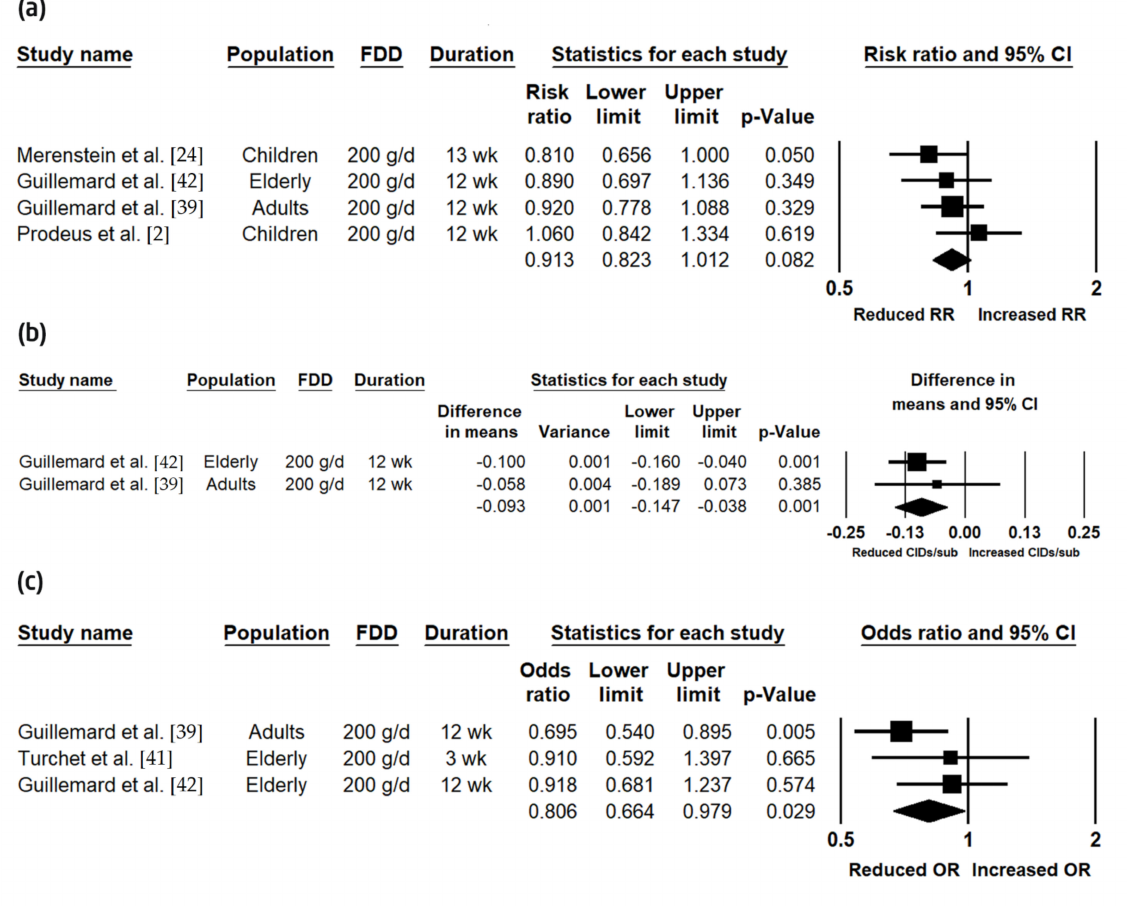
Figure 2. E ff ects of the fermented dairy drink containing Lacticaseibacillus paracasei subsp. paracasei CNCM I-1518 and the standard yogurt cultures (FDD) compared to the control on: ( a ) incidence relative risk (RR); ( b ) the mean number of common infectious diseases (CIDs) per subject; ( c ) the odds of experiencing ≥ 1 CID. CI: confidence interval; g / d: g / day; OR: odds ratio; wk: